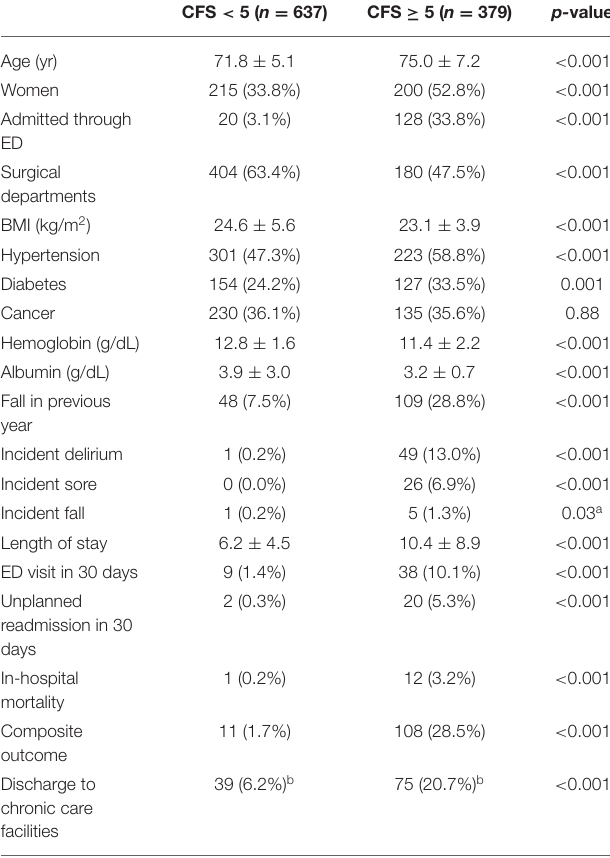
TABLE 1 | Clinical characteristics of the study